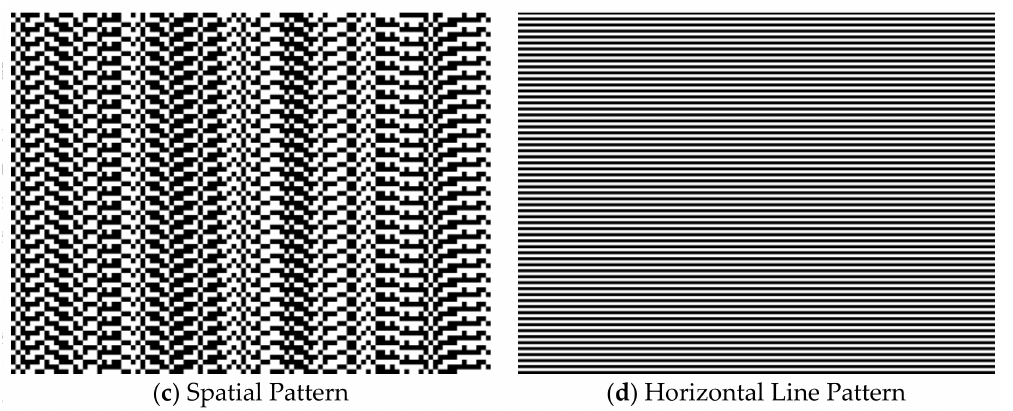
Figure 1. Structured light patterns projected through Field Programmable Gate Array (FPGA): ( a ) Hierarchal Orthogonal Coded patterns (HOC); ( b ) Gray Code Inverse (GCI) patterns; ( c ) Spatial patterns; and ( d ) Horizontal Line patterns, ( c , d ) combined are hybrid patterns that are